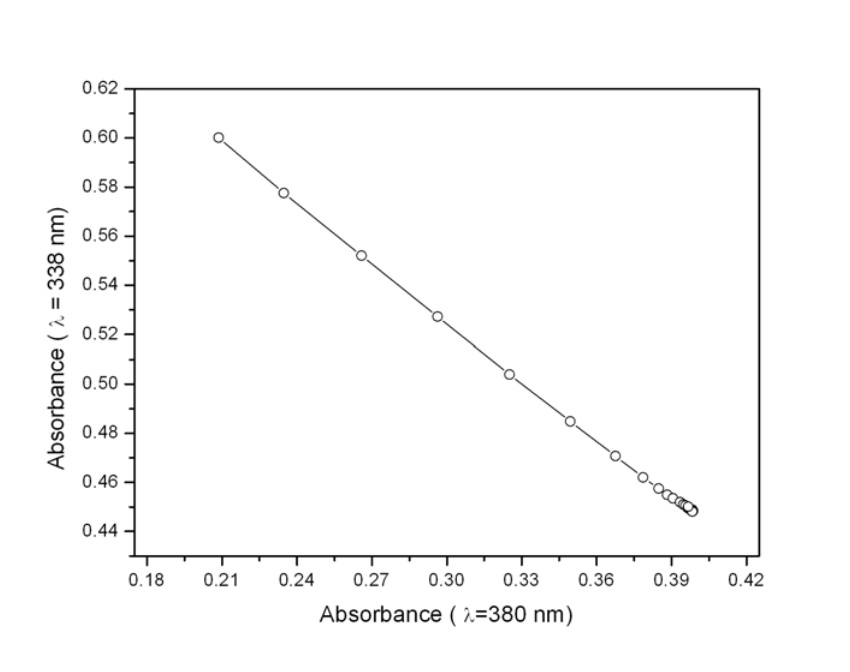
Fig. 3b Absorbance-absorbance diagram for measurements of A18C6-Dns with calcium perchlorate in acetonitrile